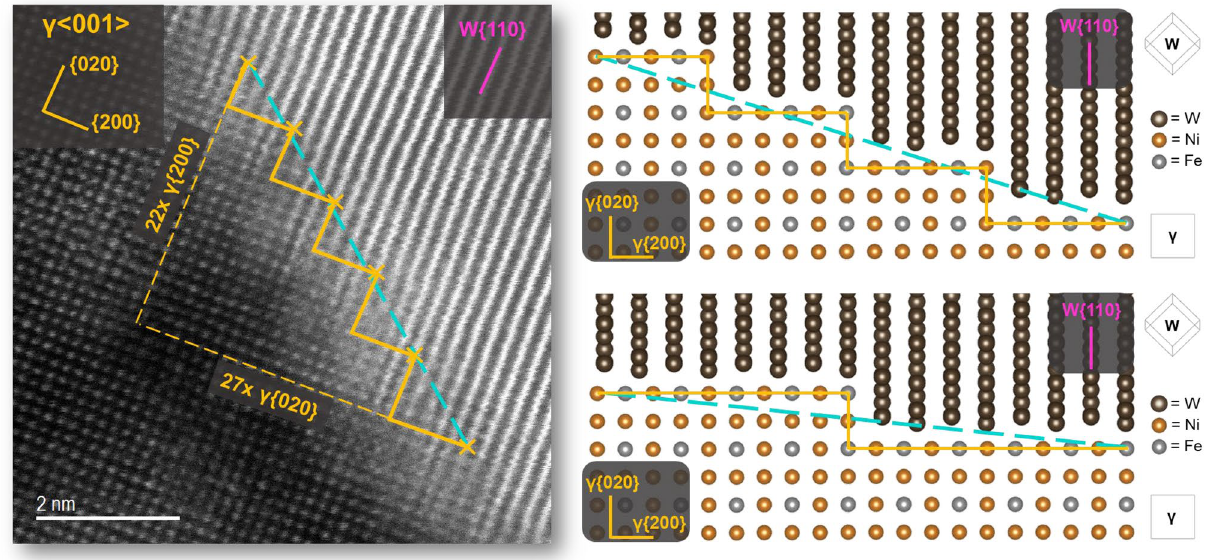
Figure 4. (Left) Atomic column STEM micrograph of on-edge interphase boundary plane highlighting stair- stepped appearance of boundary plane. (Right top and bottom) Diagrams of atomic structures comparable to that of the micrograph shown on the left defining two different interphase boundary planes which maintain the same OR and misfit dislocation spacing with different boundary planes.